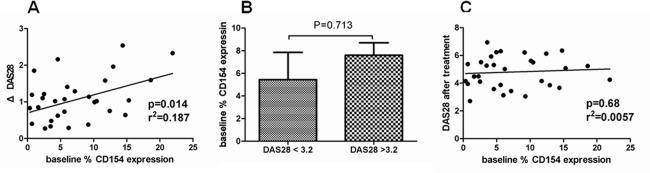
Relationship between baseline CD154 expression and clinical outcome after TNF-α blockade treatment in RA patients.(A) The correlation between the baseline CD154 expression levels (% CD154 of gated CD4+ T cells measured by flow cytometry) and the change of RA disease activity index DAS28 after TNF-α blockade treatment for 3 months. (B) Comparison of baseline CD154 expression levels between RA patients with and without low disease activity (DAS28 <3.2) after TNF-α blockade treatment. (C) The correlation between the baseline CD154 expression levels and the RA disease activity index DAS28 after 3-month TNF-α blockade treatment.